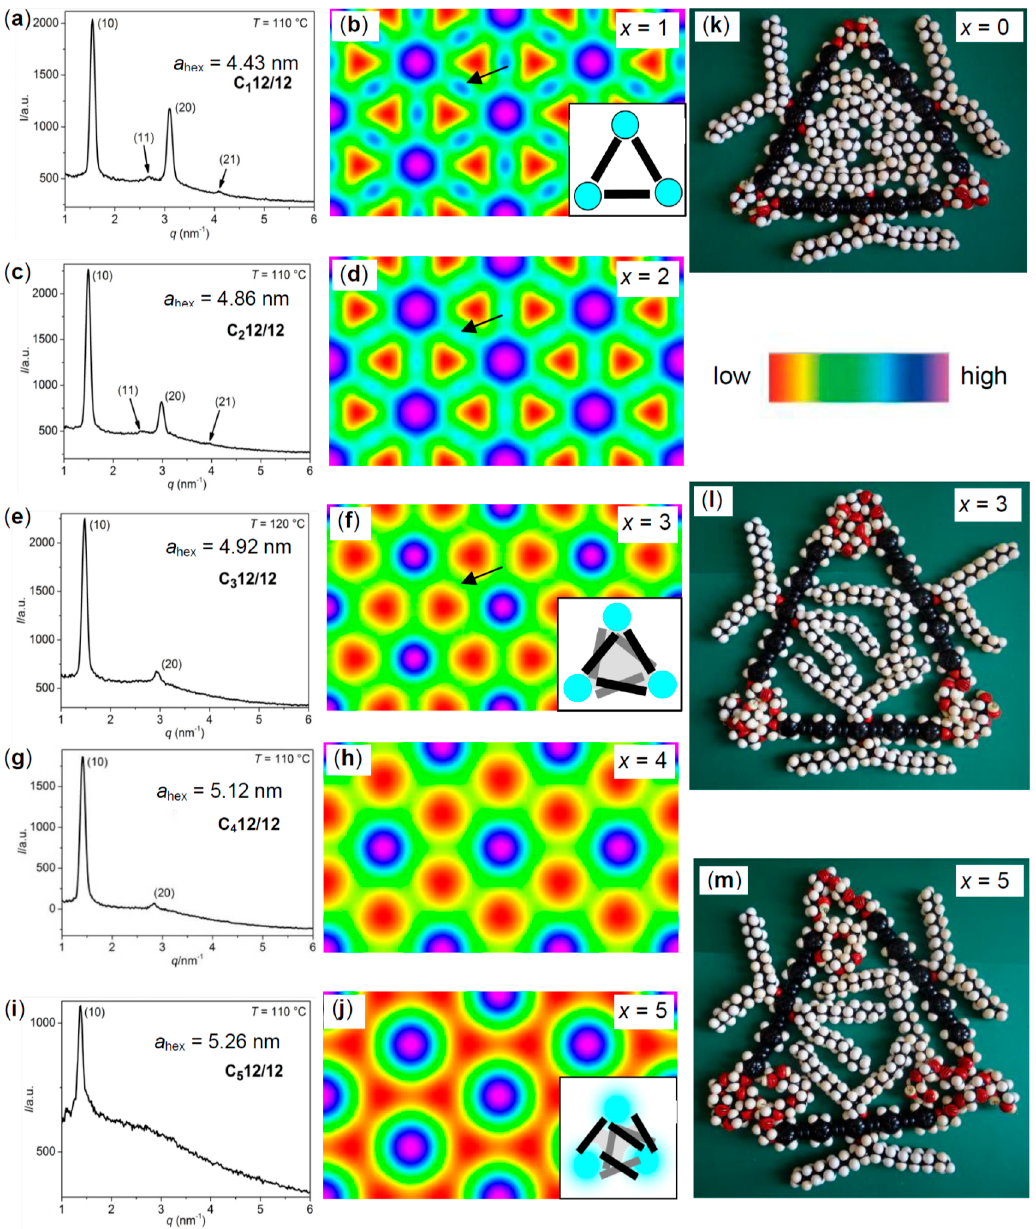
Figure 11. ( a , c , e , g , i ) SAXS patterns and ( b , d , f , h , j ) the derived ED maps of the Col hex phases (for used phase combinations, see Table S2) of compounds C x 12/12 depending on x ; ( k – m ) show models of three molecules C12/12 , C 3 12/12 , and C 5 12/12 , respectively, forming a triangular cell with the correct dimensions; for ( k ) and especially ( l ), reduced order of the OPE cores and partial mixing of EO and alkyl chains leads to improved space filling. The insets show the models of the phase structures; for numerical XRD data, see Table S2, the WAXS patterns are displayed in Figure S6.